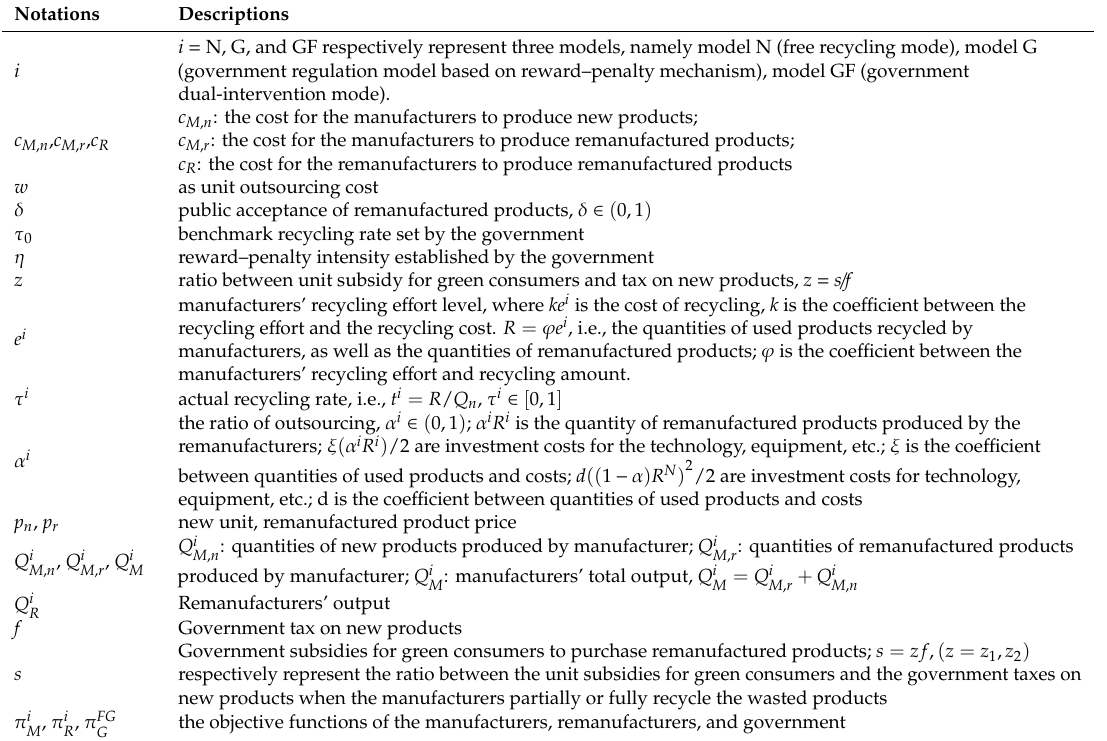
Table 1. Parameters and